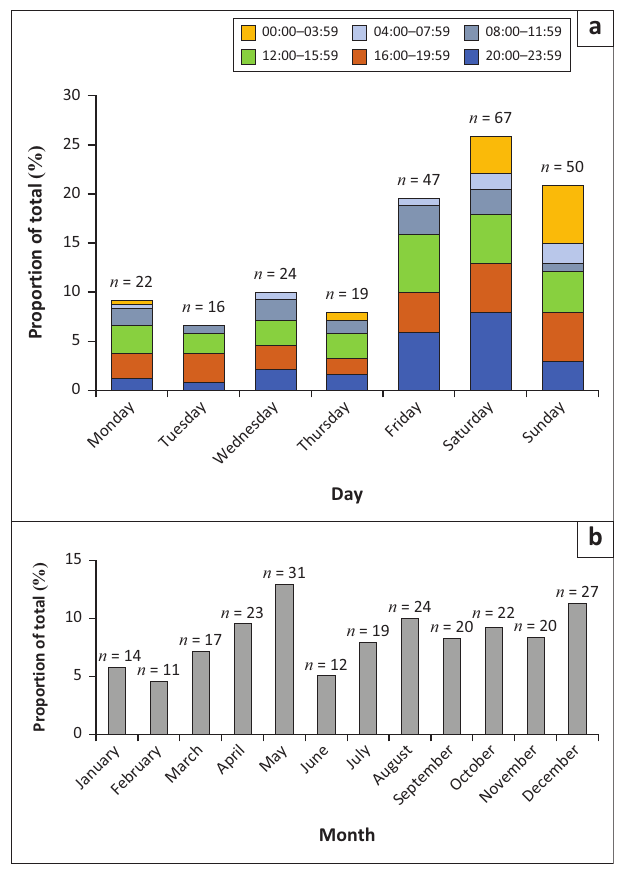
FIGURE 2: Frequency and distribution of ocular trauma ( n = 240) according to (a) time, day and (b)